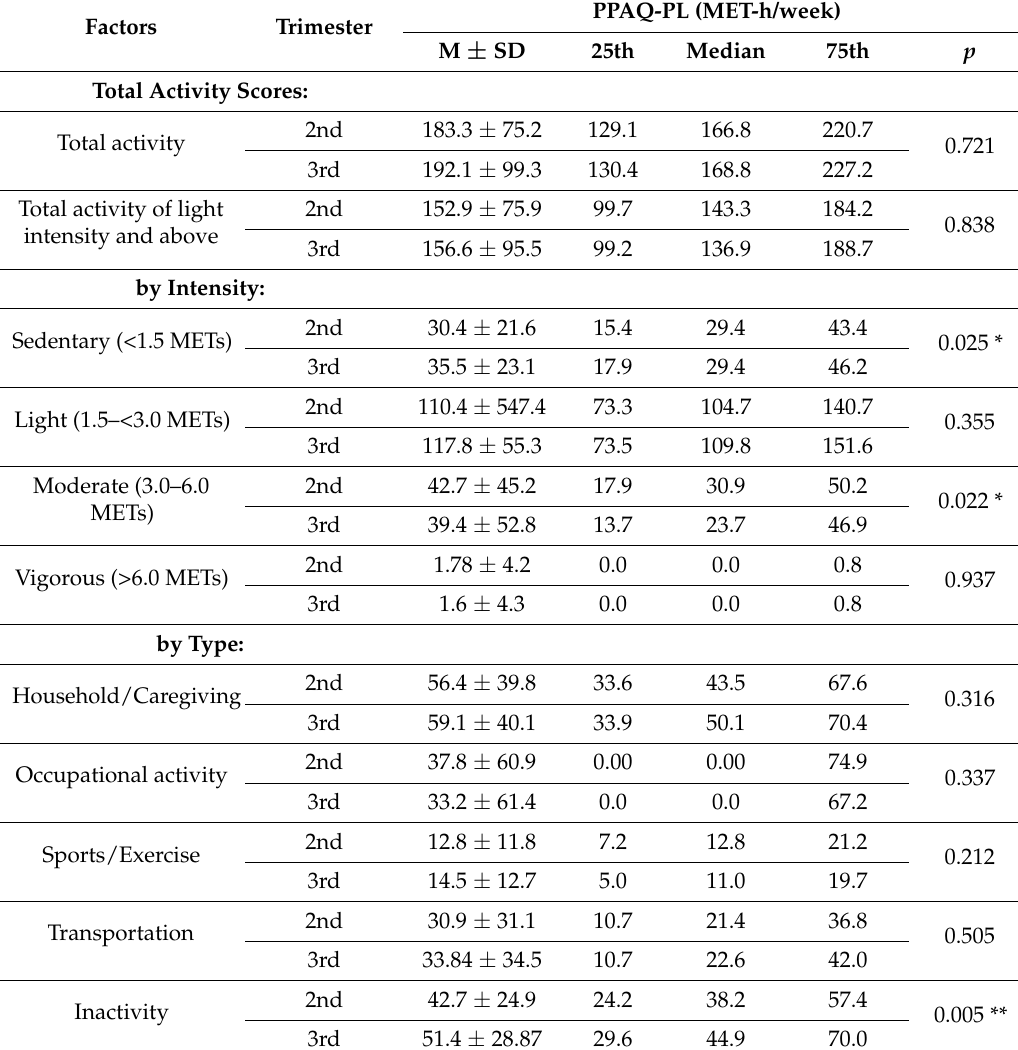
Table 1. Means (M), standard deviations (SD), medians, and 25th and 75th percentiles for the Pregnancy Physical Activity Questionnaire (PPAQ-PL) and intergroup comparisons (the second and third trimesters) using the Mann–Whitney